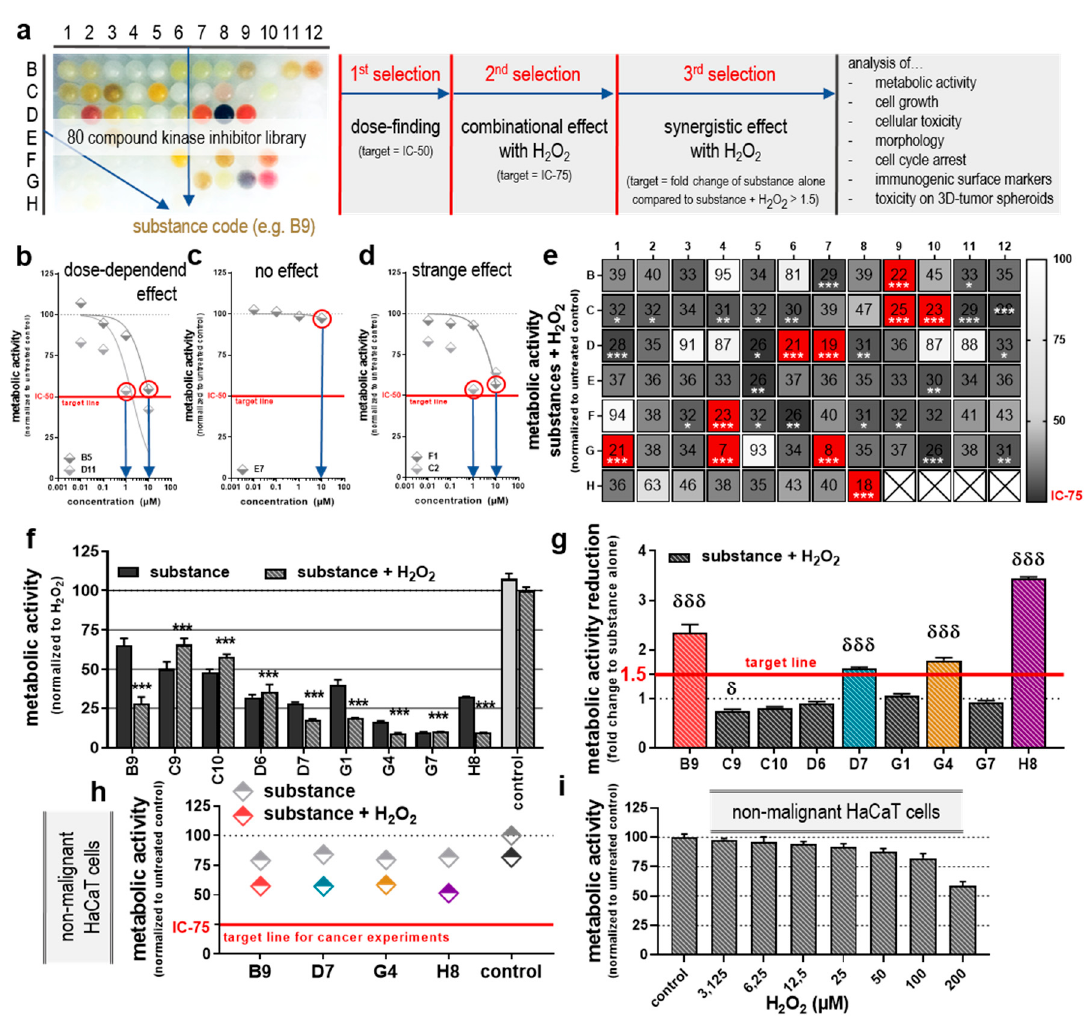
Figure 1. Experimental procedures and selection of kinase inhibitors. ( a ) Experimental strategies for the identification of selected kinase inhibitors with synergistic e ff ect with H 2 O 2 out of a 80 compound inhibitor library; representative drugs that show ( b ) dose-dependent, ( c ) no, or ( d ) an odd e ff ect on the reduction of cancer cell metabolic activity 24 h post-incubation with the kinase inhibitors and the concentration that was chosen to reach 50% of reduction (blue arrows); ( e ) metabolic activity of cancer cells with its numerical value that had received kinase inhibitors together with H 2 O 2 for 24 h (red: substances that reached 75% reduction in combination with H 2 O 2; crossed fields: no substances tested); ( f ) detail view of the cancer cell metabolic activity + SEM 24 h post-incubation with substances alone or in combination with H 2 O 2 ; ( g ) increase of metabolic activity reduction + SEM of substances + H 2 O 2 compared to substances alone, and selection (red line) of four inhibitors with a fold change of this increase > 1.5 (colored bars); ( h ) metabolic activity of non-malignant HaCaT keratinocytes that received the four selected kinase inhibitors alone or in combination with H 2 O 2 ; ( i ) metabolic activity of non-malignant HaCaT keratinocytes exposed to H 2 O 2 in di ff erent concentrations. Significance levels for the comparison of substances without H 2 O 2 to the respective substances with H 2 O 2 ( δ ), and of their combination (with H 2 O 2 ) to the H 2 O 2 -alone control (*) were determined via ANOVA. Data are representatives out of three (b–e) or two (f–i) independent replicates.